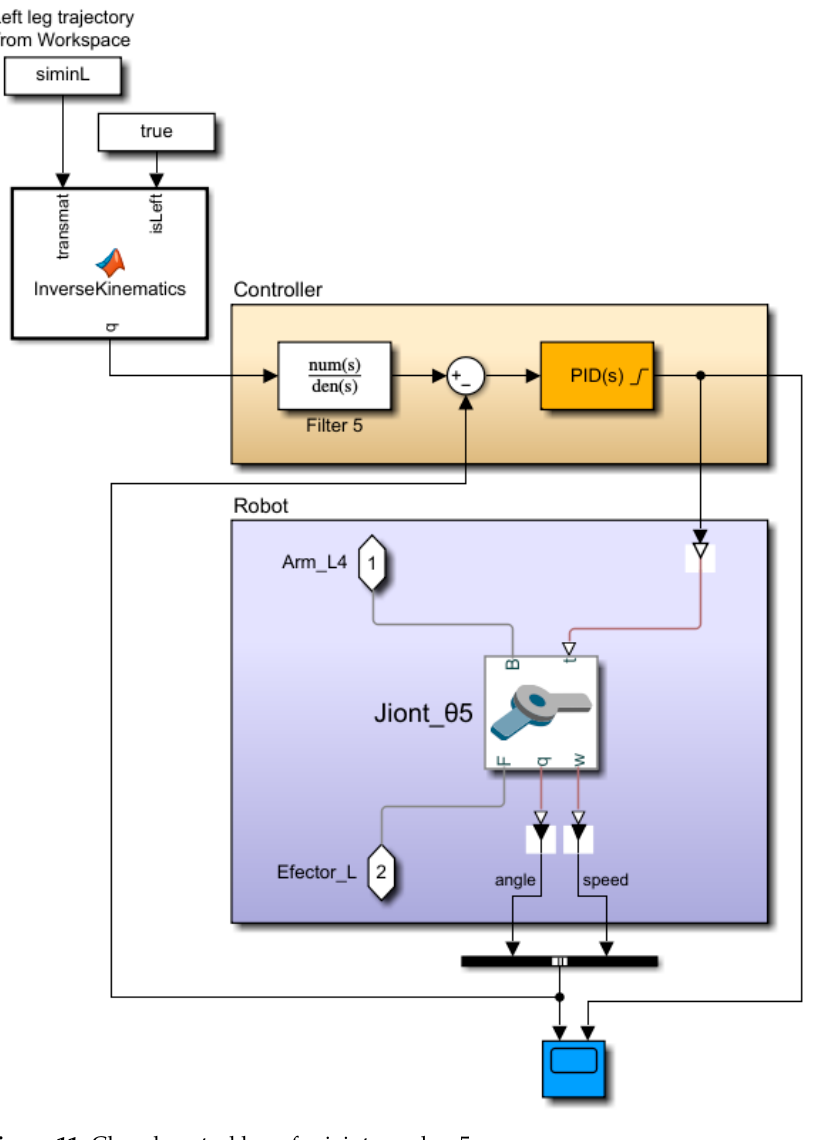
Figure 11. Closed control loop for joint number 5.